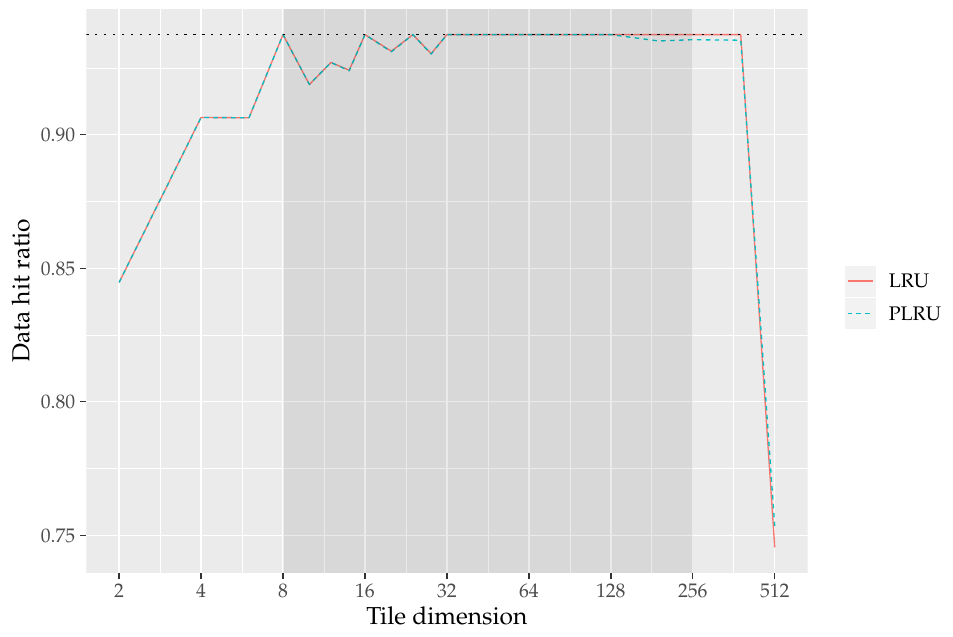
4096 matrix transposition (the higher the better) of LRU and PLRU Figure 10. Data hit ratios for 4096 × on a common L1 data cache configuration (64 sets, 8 ways, and 64 B per line, with a total size of 32 KiB). Black dotted line shows the upper bound hit ratio of eq.